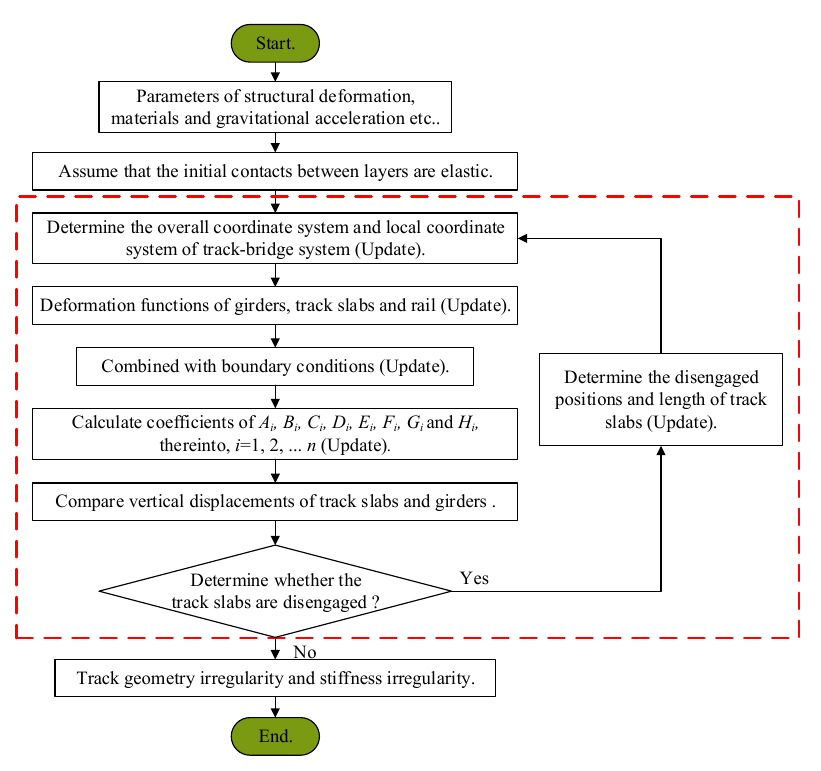
Figure 3. Flowchart of calculation process for AM-2.